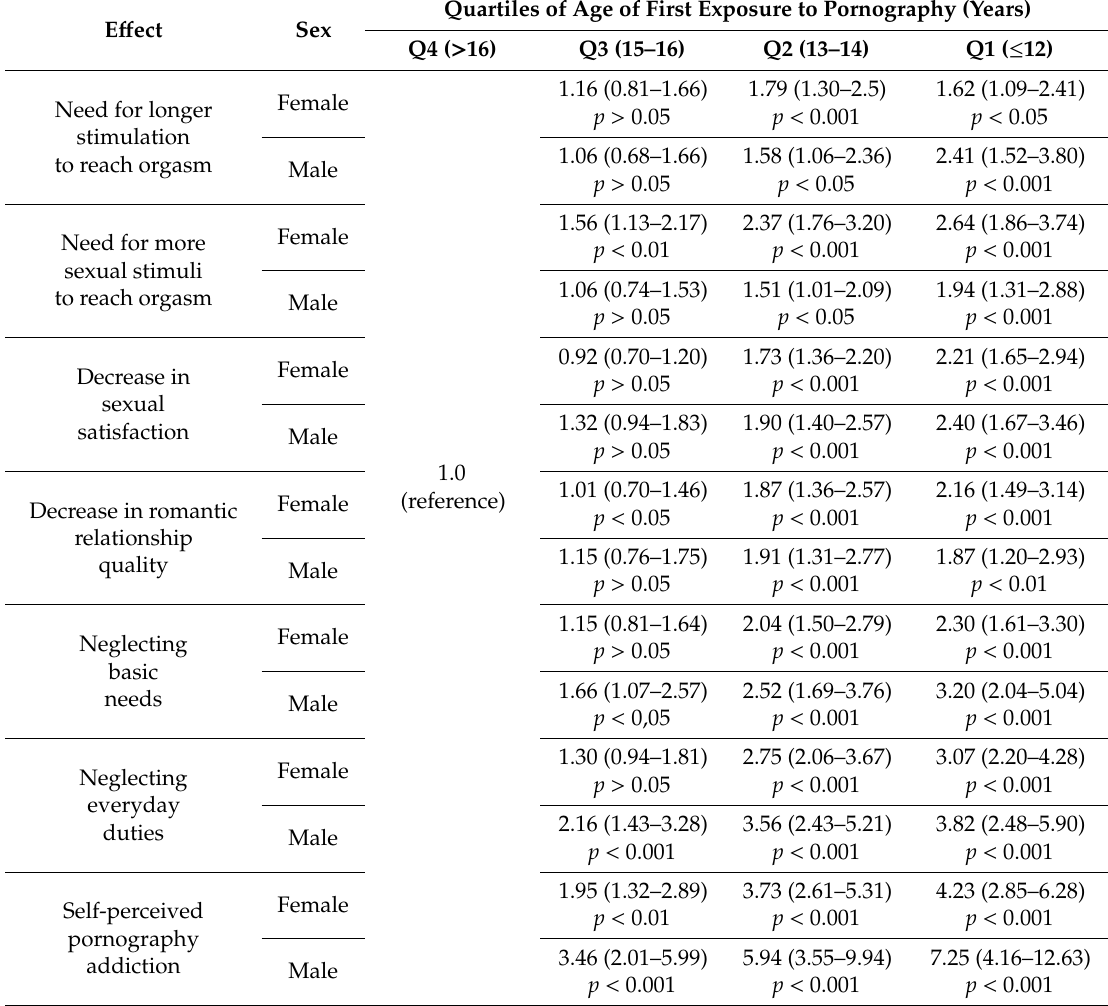
Table 3. The odds ratio (95% confidence interval) for di ff erent e ff ects of pornography use in association with age of first exposure in female ( n = 3004) and male ( n =